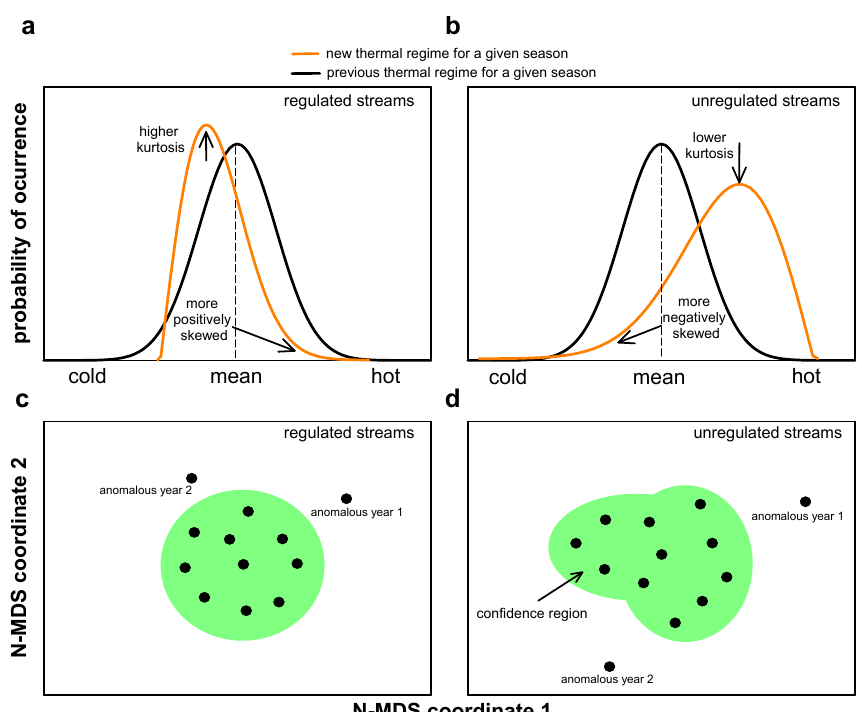
Figure 1. Conceptual diagram showing hypothesized shifts of distribution of water temperatures at both seasonal (upper panels) and annual (lower panels) scales in regulated (left panels) and unregulated (right panels) streams. In the upper panels examples of changes in skewness and kurtosis are shown for temperature distributions affected by stream regulation and a warming climate in a given season. For instance, in regulated streams the influence of the reservoir may reduce both extreme cold and warm temperatures confounding the effect from the climate (a) whereas less cold temperatures and an overall shift toward warming values may occur in unregulated streams (b) . In the lower panels, we illustrate the use of N-MDS and HDR plots for detecting potentially anomalous years in regulated and unregulated streams (the shaded area represents a given coverage probability). Points located in the outer or the confidence region represent potentially anomalous years. For instance, in regulated streams individual years are more clustered because the reservoir may homogenize temperatures across years (c) whereas in unregulated streams individual years are less clustered due to more heterogeneous responses to the warming climate (d)